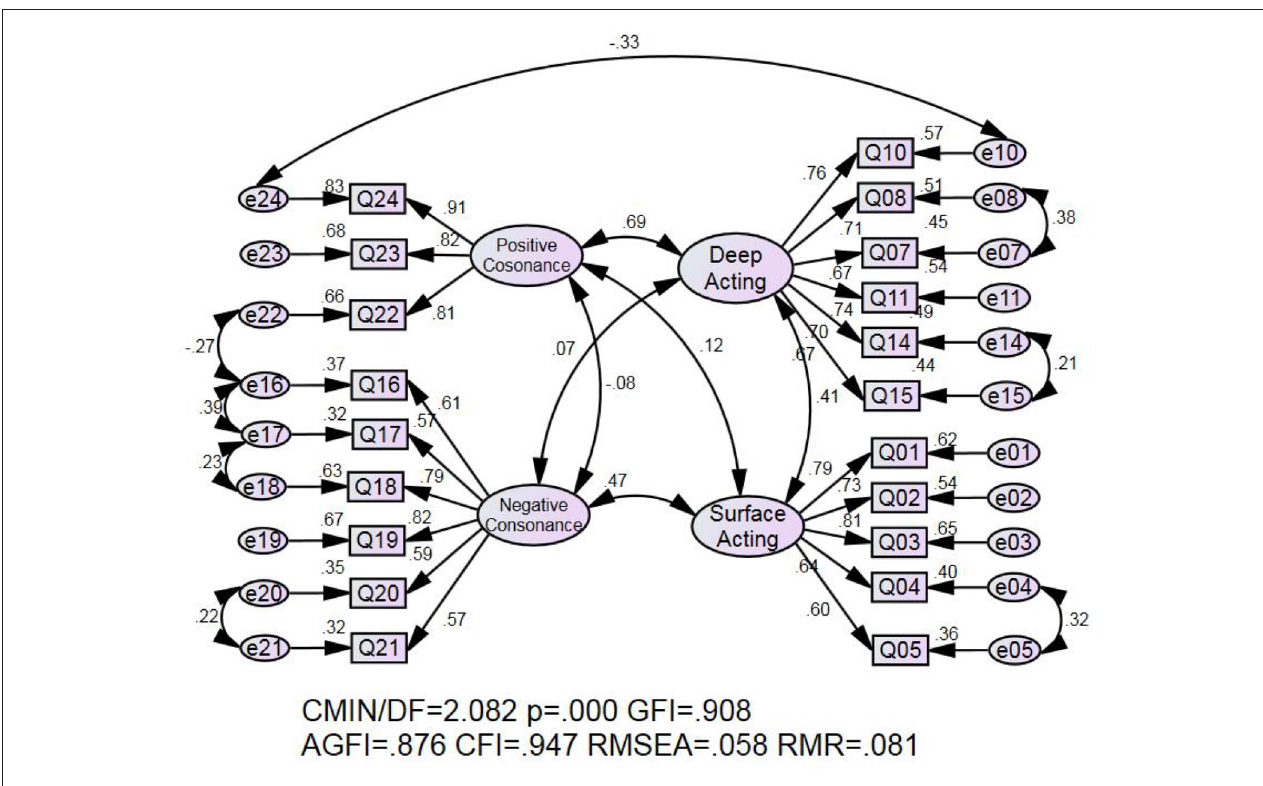
FIGURE 1 | Graphical representation of the four-factor model and factor loadings.